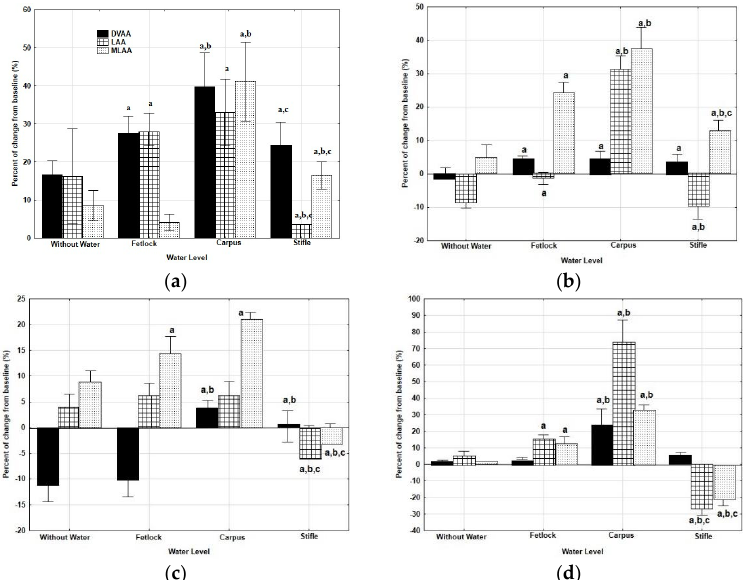
Figure 2. Median and quartiles of the percent of change from baseline of the total accelerometric activity, measured on a track after WT exercise sessions at four different water depths, at walk and at trot and with the accelerometer in two different positions (PECT, in the pectoral region; SML, in the sacrum midline) (( a ): at walk with the accelerometer in PECT position; ( b ): at trot with the ac- celerometer in PECT position; ( c ): at walk with the accelerometer in SML position; ( d ): at trot with the accelerometer in SML position) a: significant differences with treadmill without water; b: signif- icant differences with water at the level of the fetlock; c: significant differences with water at the level of the carpus. p < 0.05. With the accelerometer in PECT position, DVAA increased significantly on the track, showing the most marked increase after WT exercise at the level of CAR at walk ( p = 0.004) and after WT exercise at levels of FET ( p = 0.031) and CAR at trot ( p = 0.028) (Figure 3). However, with the accelerometer in SML position, DVAA increased after WT exercise at CAR level ( p = 0.032). CAR level ( p = 0.032).